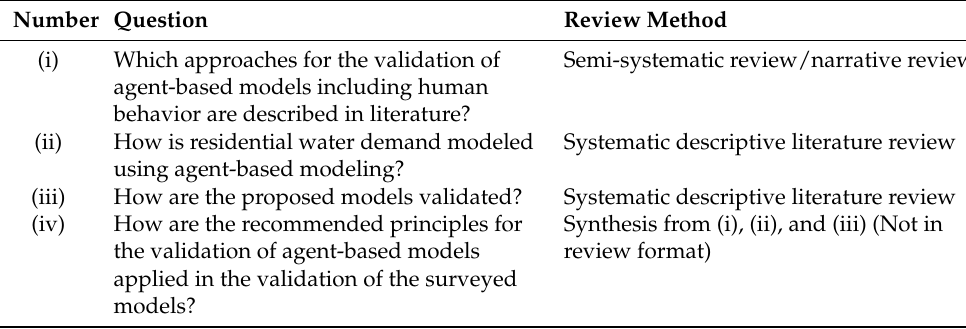
Table 1. Research questions and used review